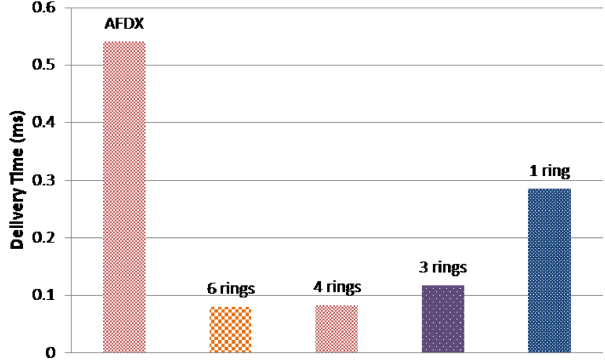
Figure 17. Maximum delivery times for traffic class HRT.